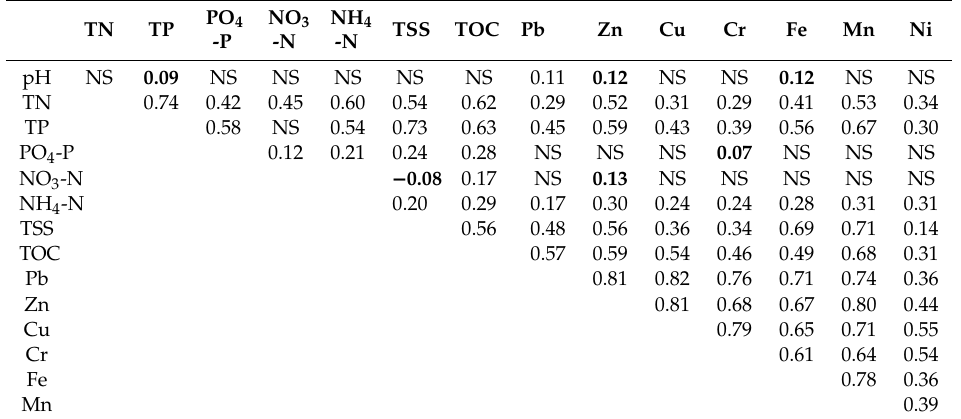
Table 2. Pearson’s correlation coe ffi cients (r) between the averages of event mean concentrations (EMCs) for water quality parameters when data of all land uses are